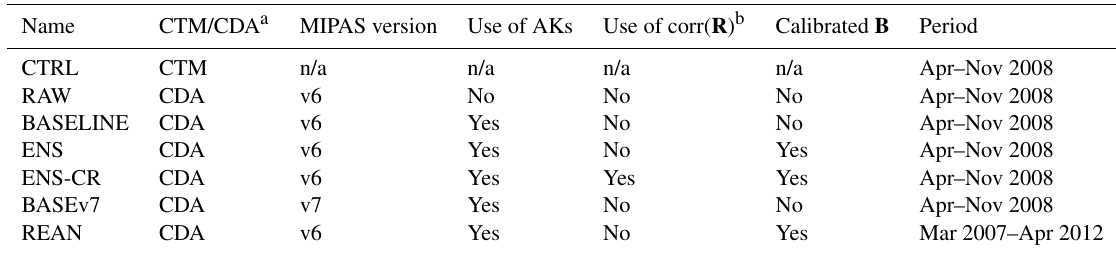
Figure 3. Zonal mean of CH 4 (ppmv) from six BASCOE experiments on 15 September 2008 at 12:00UT and from MIPAS measured on the same date (see text for details). Here MIPAS data are binned on a 5 ◦ latitude grid and a pressure grid with 6 levels per decade of pressure. Table 1. List of BASCOE experiments discussed in this